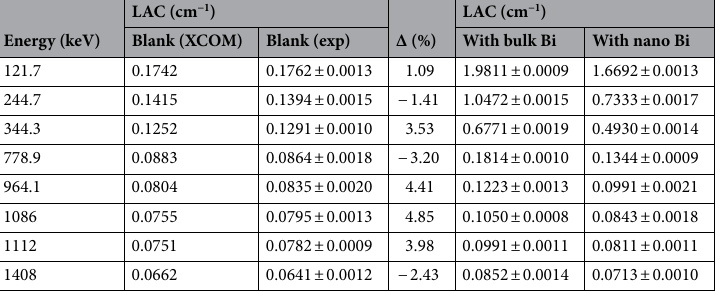
Table 3. The LAC for different investigated samples and the pure PLA polymer (blank) compared with the XOM results and its uncertainty.